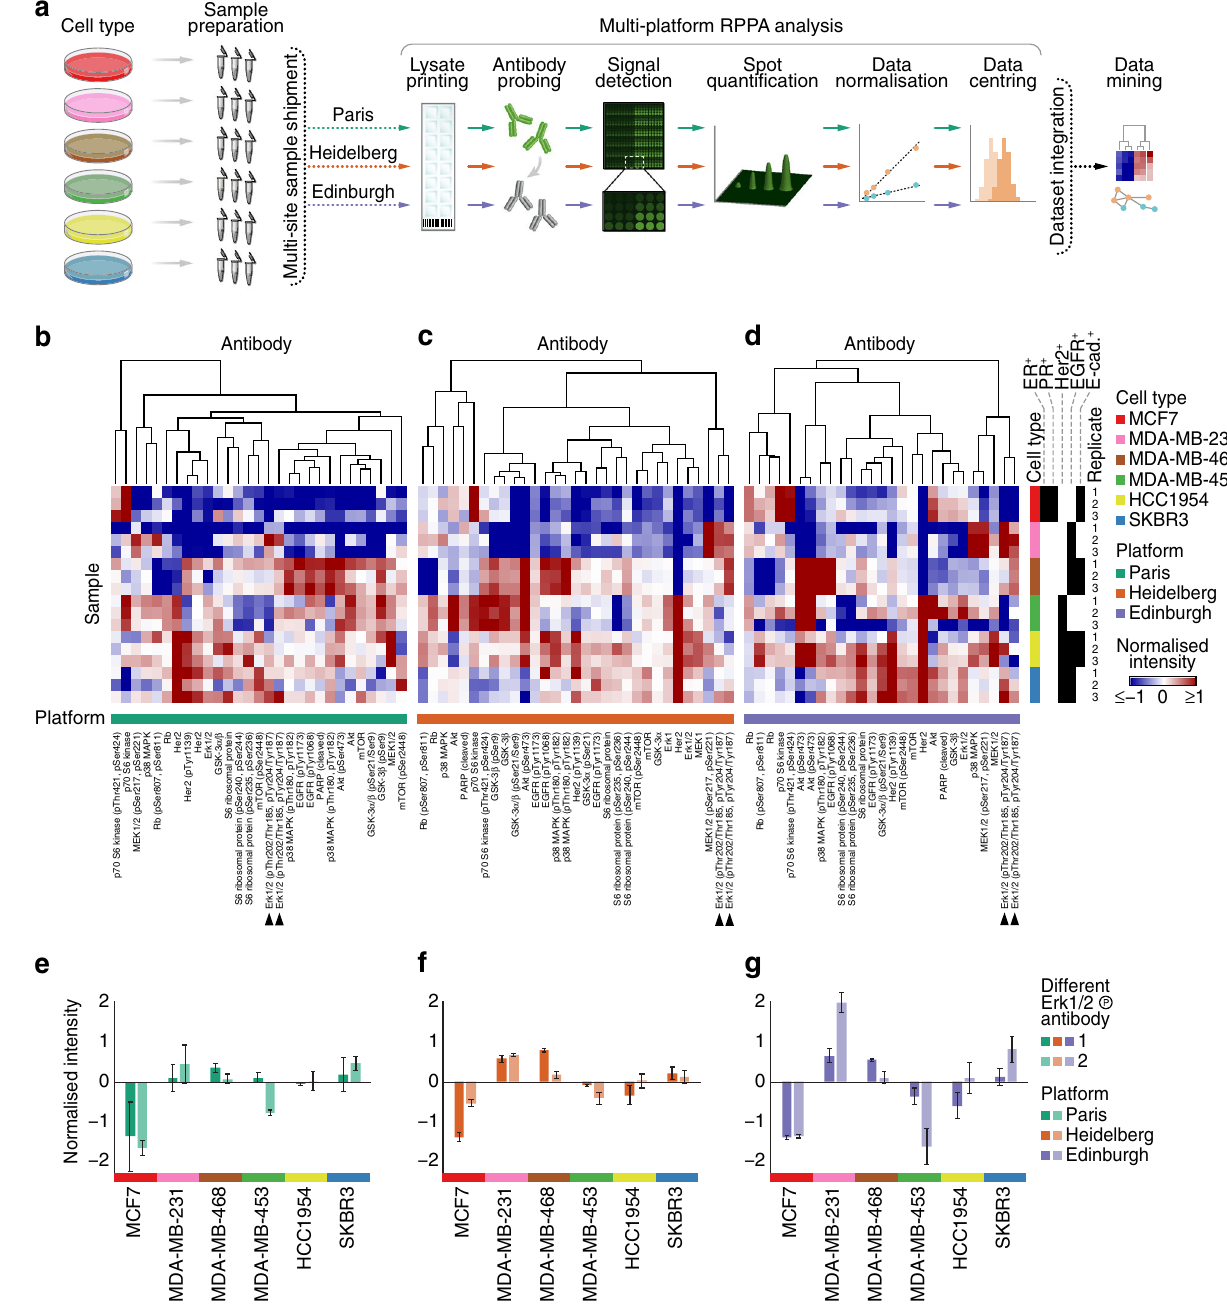
Figure 1. Multi-platform RPPA analysis of breast cancer cell lines. ( a ) Schematic illustration of the multi- platform RPPA workflow. Images created using Illustrator. ( b – d ) Hierarchical cluster analysis of RPPA data of six breast cancer cell lines cultured under control conditions derived from three RPPA platforms. RPPA data derived from the Paris ( b ), Heidelberg ( c ) and Edinburgh ( d ) platforms were clustered on the basis of antibody- wise dissimilarity (Spearman rank correlation coefficient-based distance). Clustering was performed separately for each platform, and sample order was maintained for each cluster analysis. Annotation bars indicate cell type, cell type receptor status and RPPA platform. Arrowheads indicate different phosphorylated Erk1/2 antibodies. ( e – g ) RPPA data for phosphorylated Erk1/2 (pThr202/Thr185, pTyr204/Tyr187) derived from the Paris ( e ), Heidelberg ( f ) and Edinburgh ( g ) RPPA platforms. All three platforms used the same two antibodies that recognise phosphorylated Erk1/2 (dark bars, antibody identifier Erk1/2_pThr202/Thr185,pTyr204/Tyr187_a; light bars, antibody identifier Erk1/2_pThr202/Thr185,pTyr204/Tyr187_b). Annotation bars ( x -axis) indicate cell type. Data are means ± s.e.m. ( n = 3 independent samples). For further details, see Supplementary Fig. S1 and Supplementary Table